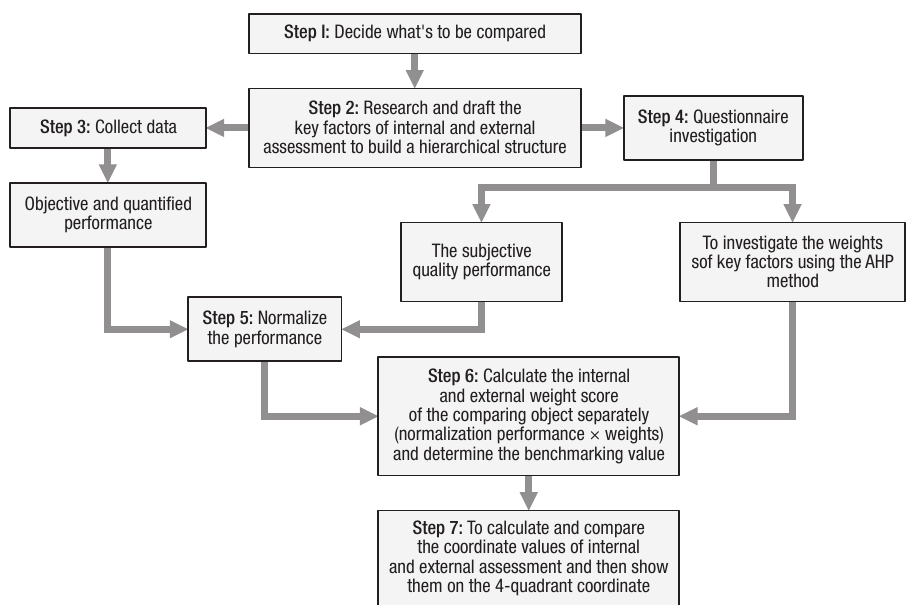
Fig. 7. Flowchart of Quantifi ed SWOT analysis pattern (Chang and Huang